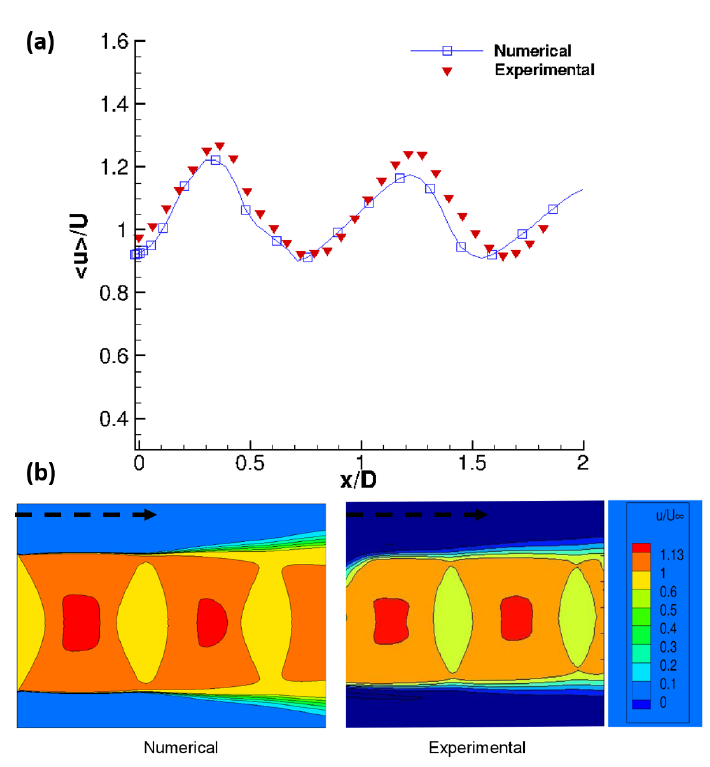
Figure 2. ( a ) Comparison of mean-streamwise velocity along the centerline of the jet; ( b ) Comparison of shock cell structure on a vertical plane. Current computational results compared with corresponding experimental values. The experimental values plotted in ( a ) has an uncertainty of 1.4% [55]. The horizontal dotted arrows indicate the flow direction in ( b